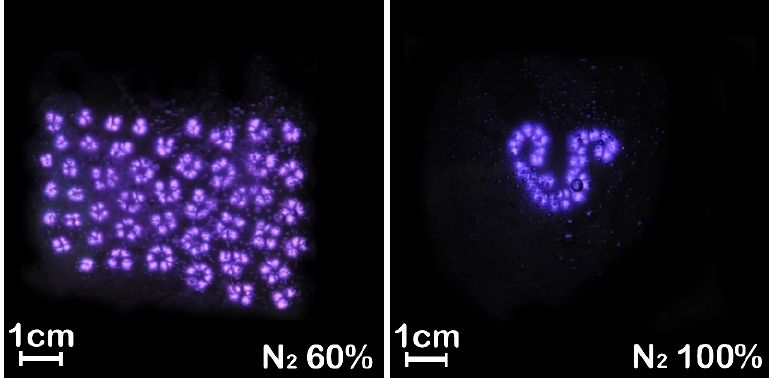
Figure 6. Photos of discharge with 60% and 100% nitrogen at 656 W. Exposure time: 1 ms.